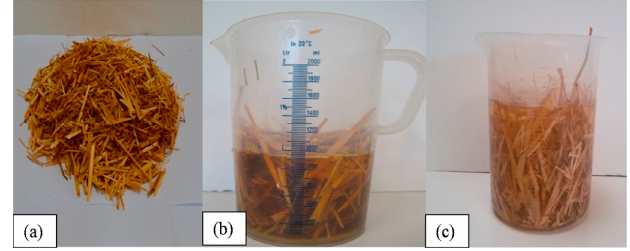
Figure 8. Treatment of straw fibers: ( a ) crushed straw, ( b ) immersion in linseed oil, ( c ) boiled water immersion [46].